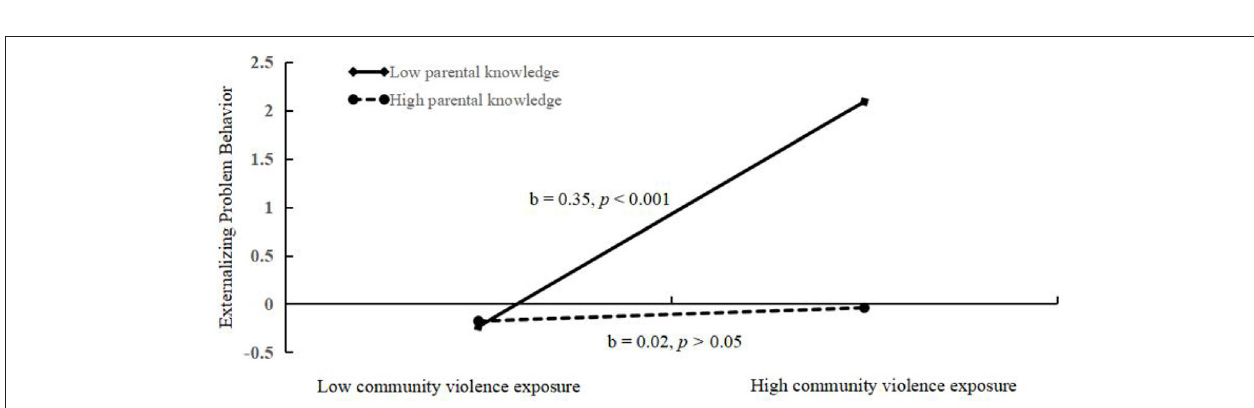
FIGURE 3 | Model of the moderating role of parental knowledge on the direct association between community violence exposure and externalizing problem behaviors. *** p < 0.001.